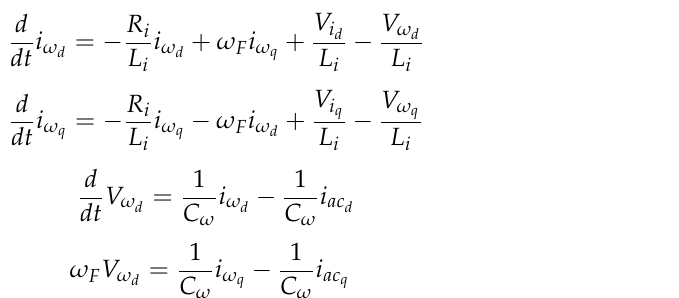
Figure 2. System of the offshore AC grid model.